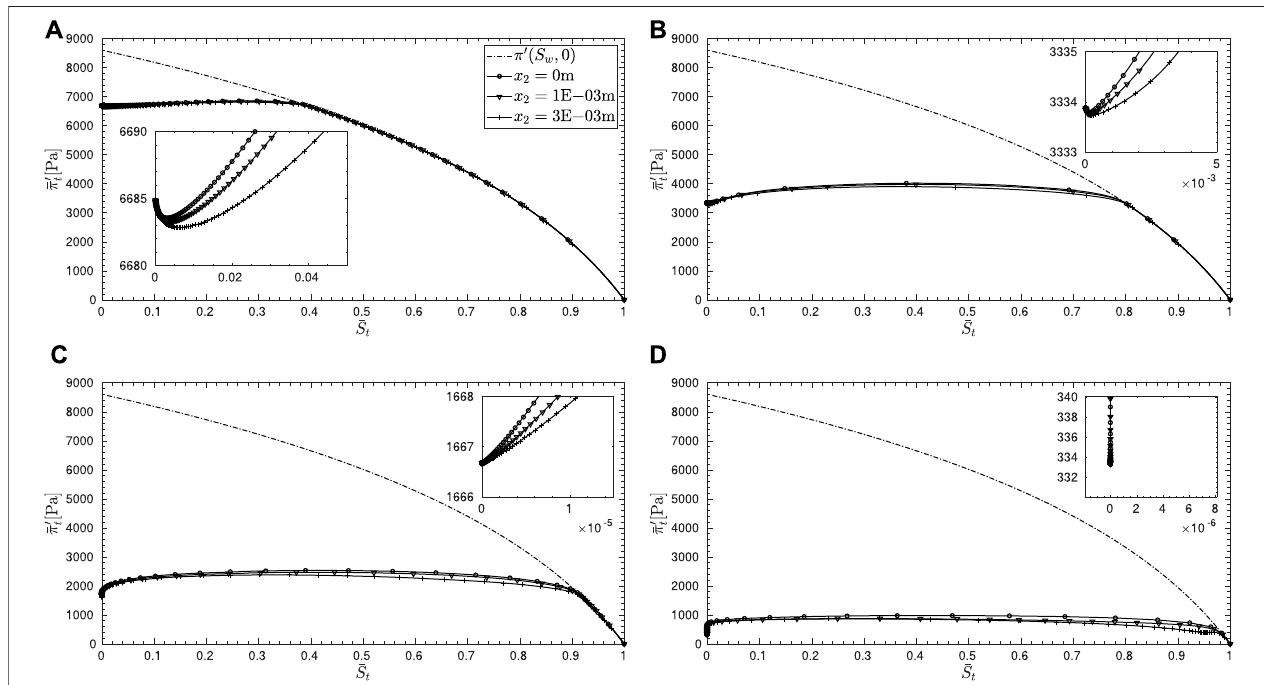
FIGURE 7 | Evolution of the functions, (cid:2) π t ′ , with S t at the boundary x 2 = 0m and two locations within the domain close to this boundary. The different values of w 1 used are (A) 2000 N.m − 3 , (B) 1000 N.m − 3 , (C) 500 N.m − 3 , and (D) 100 N.m − 3 . In each plot, the possible evolution if damage remains vanishing π ′ ( S w , 0 ) isalso plotted for